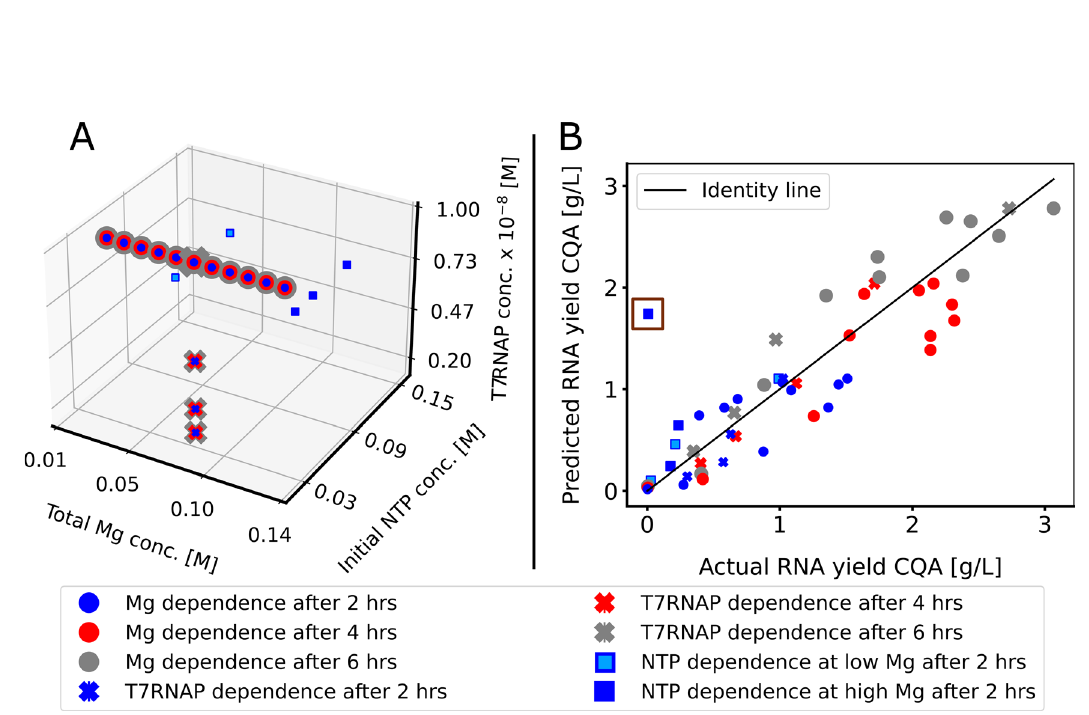
Fig. 2 Experimental data distribution and modelling error plots. A Three-dimensional plot showing the experimental data generated using a statistical Design of Experiments approach. Data points of different colour overlap. This data was used for model calibration and validation. B Modelling error plot. The x -axis represents the true experimental RNA yield, and the y -axis marks the corresponding prediction from the model. Each point (circle, square or x ) is a prediction generated using the model. The black line represents the identity line, where modelling results perfectly match the experimental outcome. The brown square encases the outlier for NTP dependence at high Mg concentration. The meaning of the colours is indicated in the legend below the